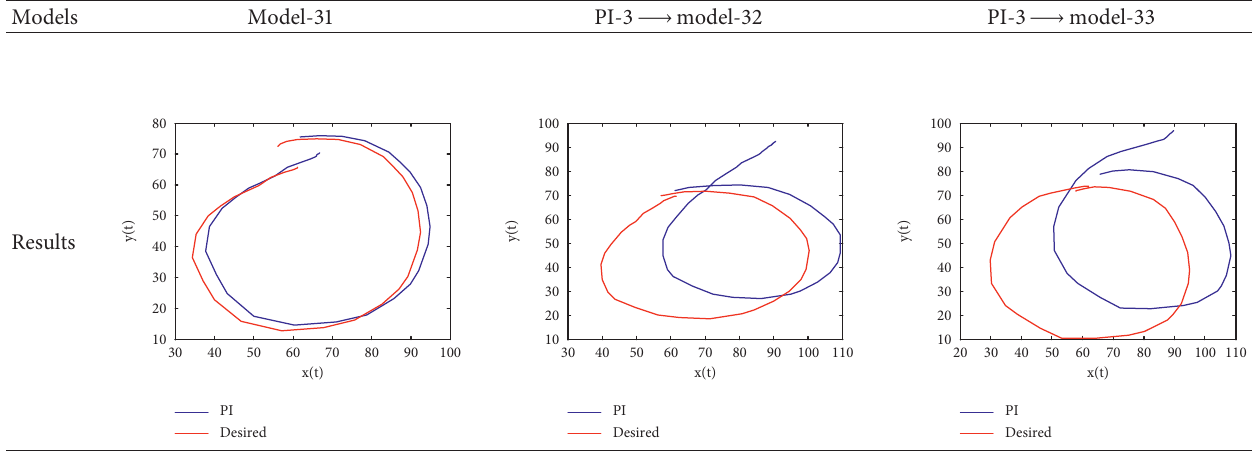
Table 6: Results of validation of the PI-3 controller applied to model-31, model-32, and model-33.